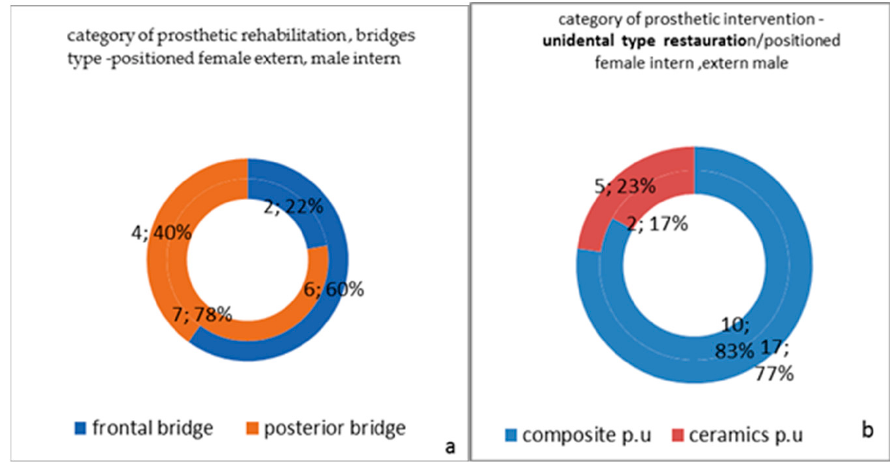
Figure 13. ( a ) Distribution of single restauration and ( b ) prosthetics devices—composites and ceramics placed in anterior or posterior arch area.